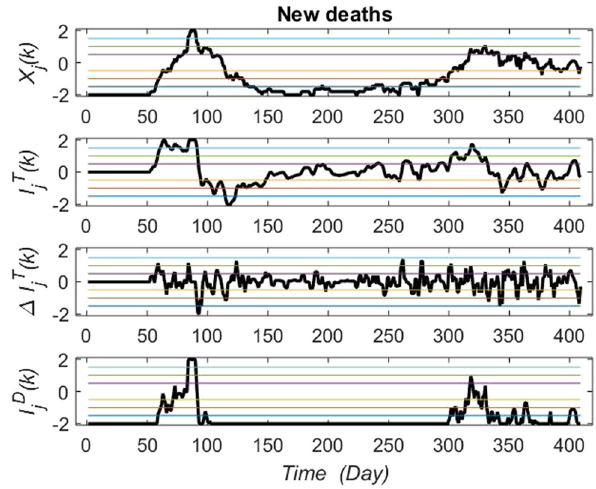
Figure 13: Temporal analysis for the new con fi rmed deaths in Finland.